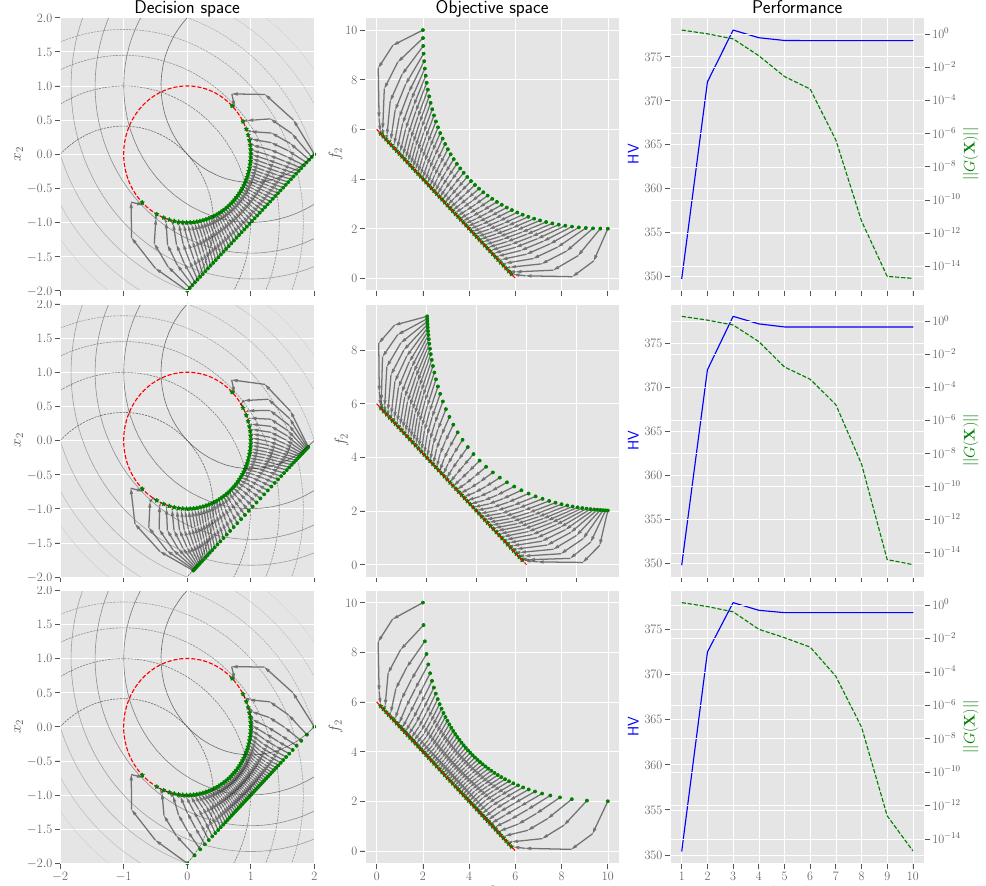
Figure 2. On problem P1, the convergence of the HVN method is shown for three different initial- izations of the starting approximation set ( µ = 50)—linear ( top row ), logistic ( middle ), and logit spacing ( bottom ). We depict the final approximation set ( left column ; green stars), the corresponding objective points ( middle column ; green stars), and the evolution of the HV value and ( right column